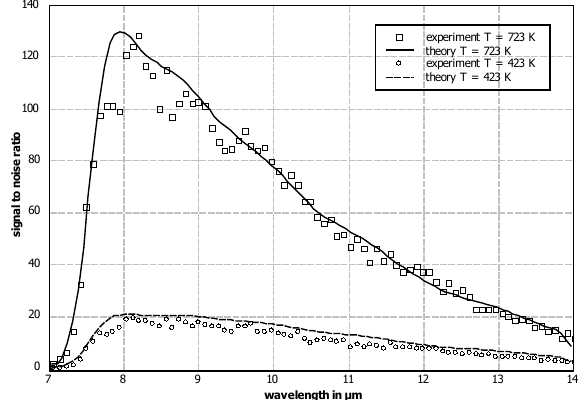
Figure 6: Comparison of experimental and theoretical determined signal to noise ratios of the MERTIS sensor. The spectral results for two different blackbody temperatures T are